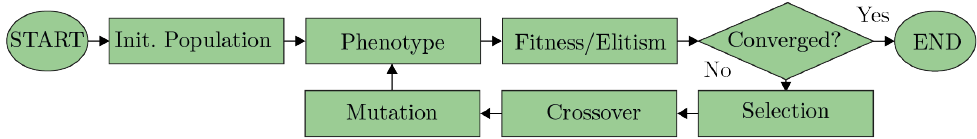
Figure 3. Genetic Algorithm flow chart.